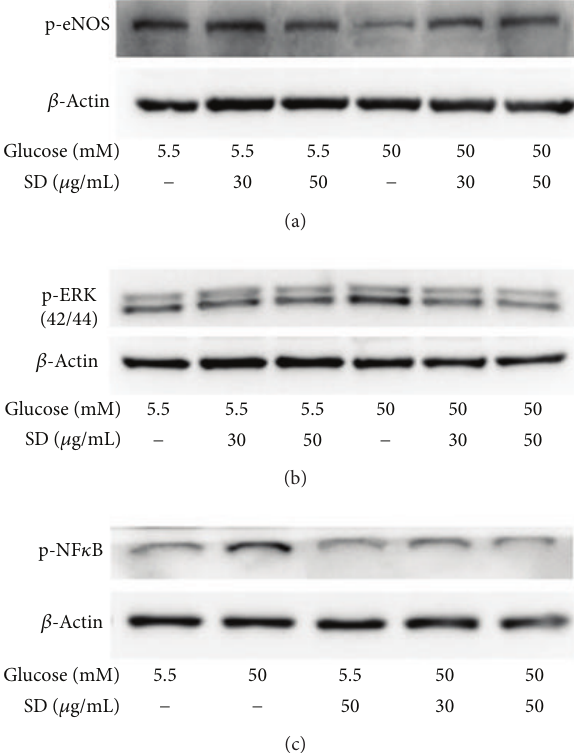
Figure 3: Effects of SD on HG-induced phosphorylation of eNOS, ERK, and NF- 𝜅 B in HUVECs: HUVECs (2 × 10 5 cells/well) were pretreated with SD (30 and 50 𝜇 g/mL) for 2 h and then treated with glucose (50 mM) for 30 min to detect the phosphorylation of (a) eNOS, (b) ERK1/2, and (c) NF- 𝜅 B. The 𝛽 -actin was used as an internal control.